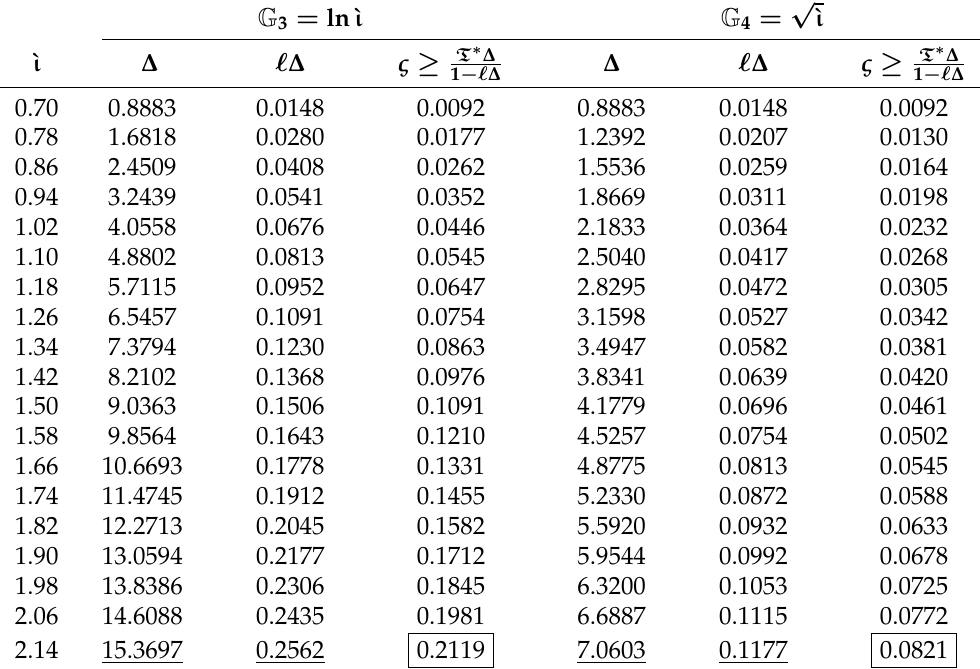
Table 2. Numerical values of ∆ , (cid:96) ∆ in Example 1 ∀ ` ι ∈ [ τ 1 , τ 2 ] when G 3 ( ` ι ) = ln ` ι and G 4 ( ` ι ) =